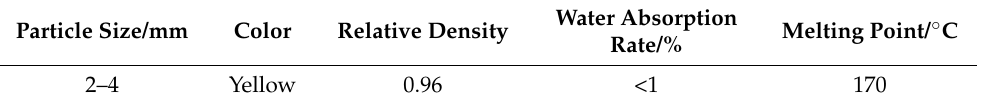
Figure 1. TPS modifier, Icebane, and limestone filler. Table 2. Basic properties of TPS.